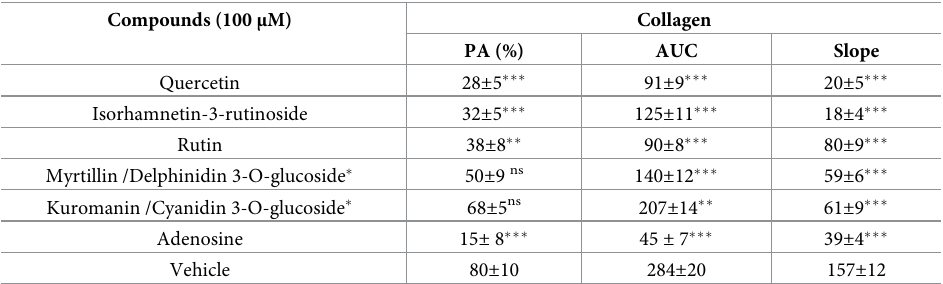
Vehicle 157 ± 12 Data are expressed as mean ± SEM, n = 6, and analyzed using one-way ANOVA. Post hoc analyzes were performed using the Tukey test